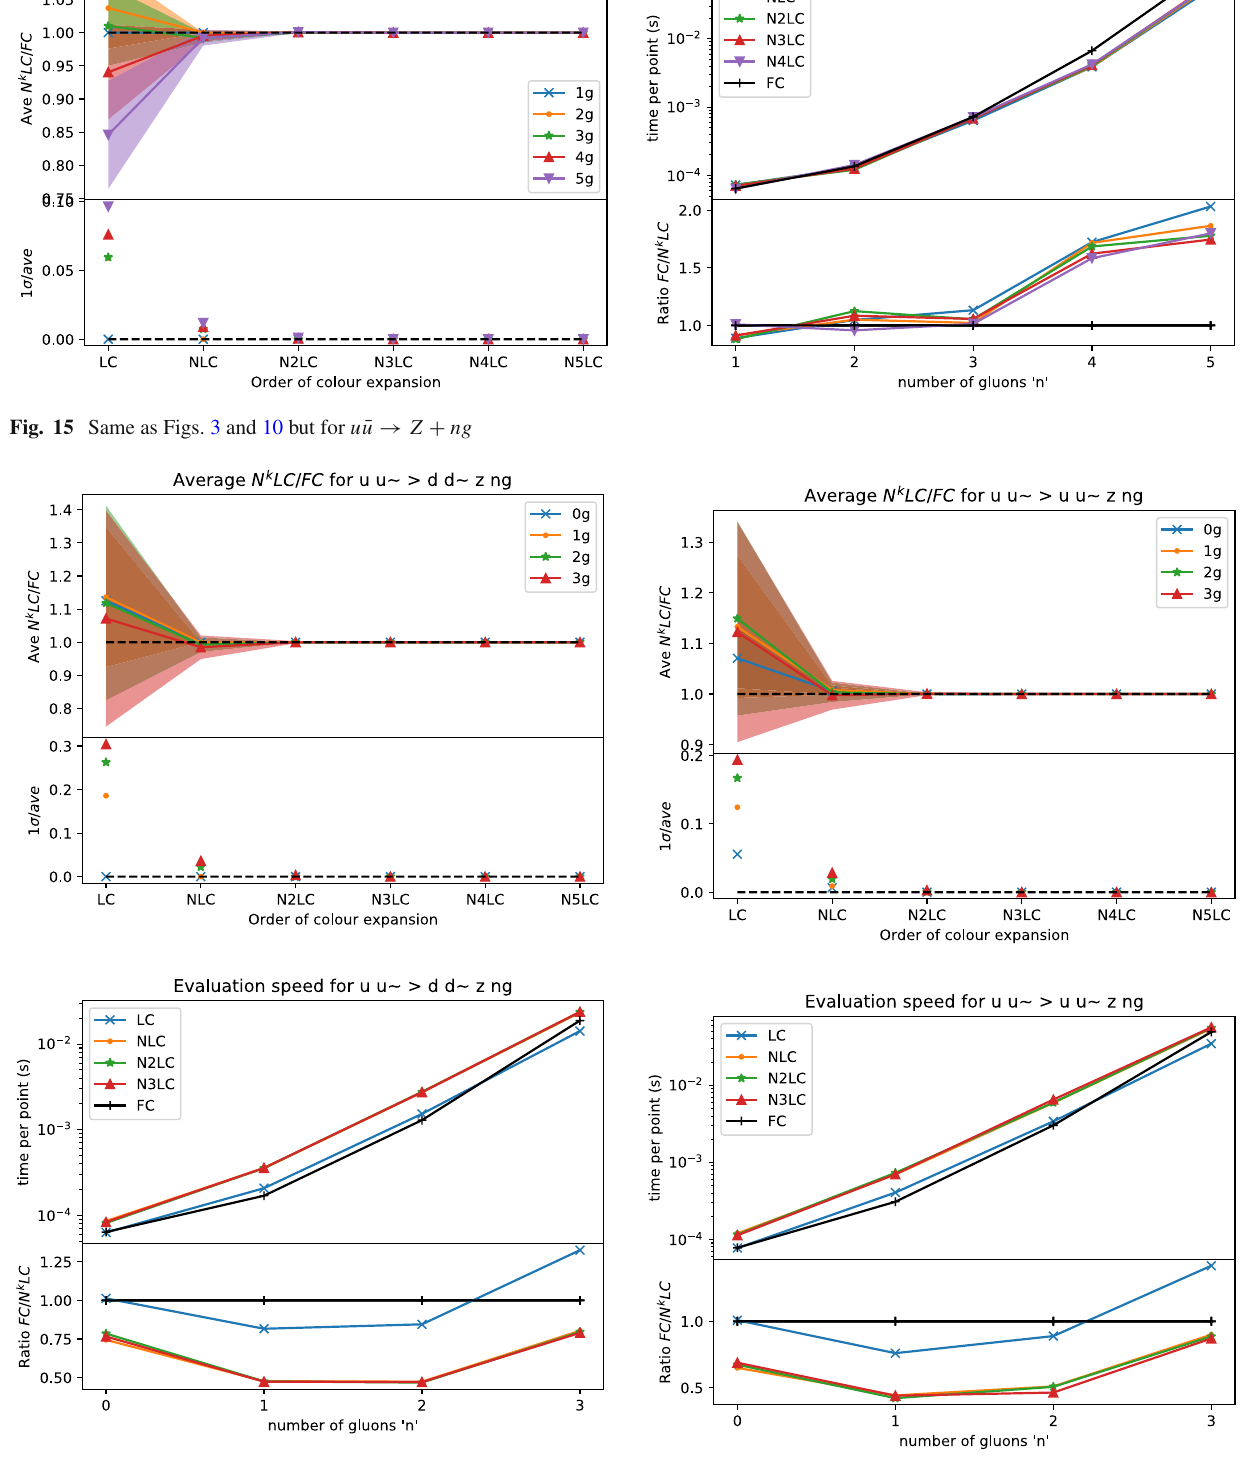
Fig. 16 Same as Figs. 3 and 10 but for u ¯ u → Z d ¯ d + ng (left) and u ¯ u → Z u ¯ u + ng